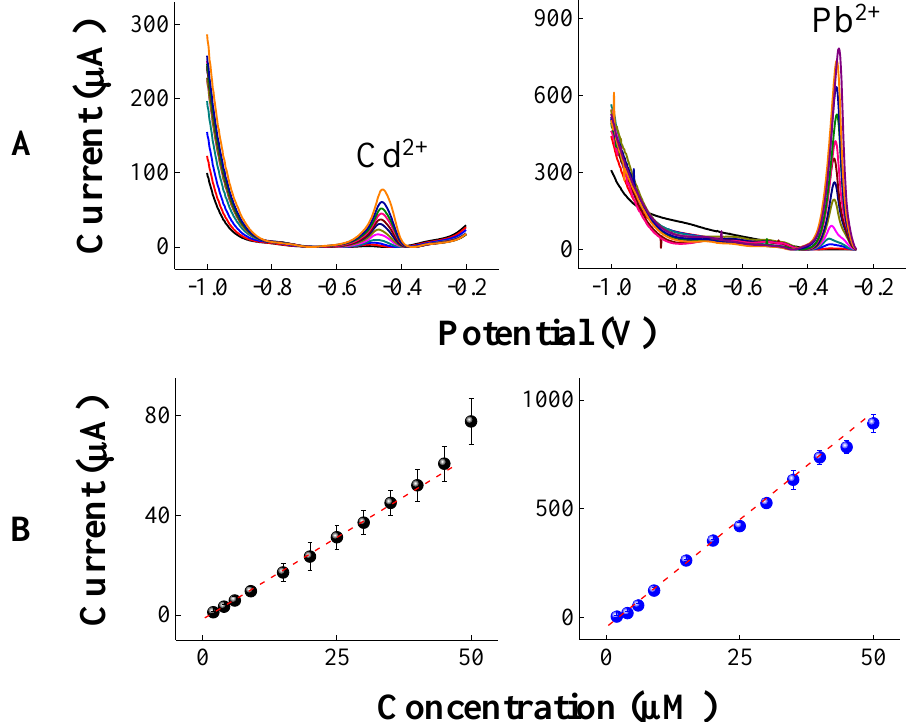
Figure 4. Differential pulse anodic stripping voltammetry in ( A ) and respective analytical curves in ( B ) for detection of Cd 2+ and Pb 2+ ions using flexible copper sensors decorated with bismuth micro/nanodentrites. Conditions: individual detection of heavy metals with the concentration varying from 2.0 μM to 50 μM in artificial sweat.